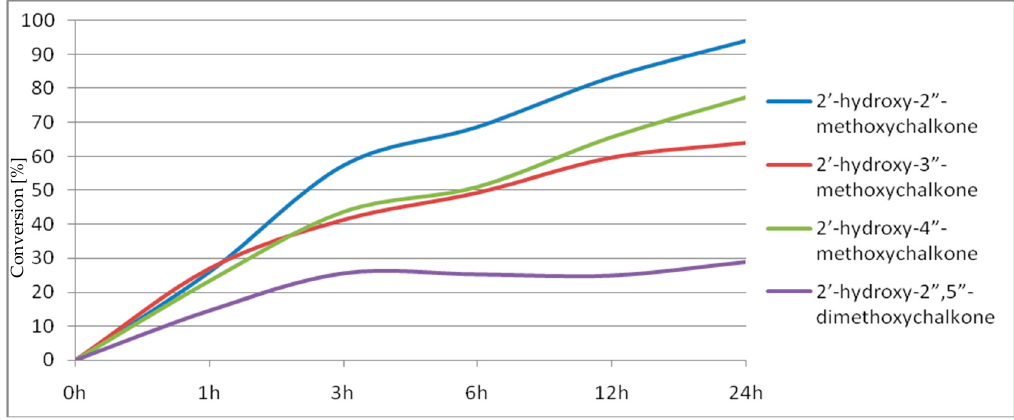
Figure 3. Comparison of conversion of selected substrates to products during 24 h incubation, for a substrate concentration of 1 g/L.